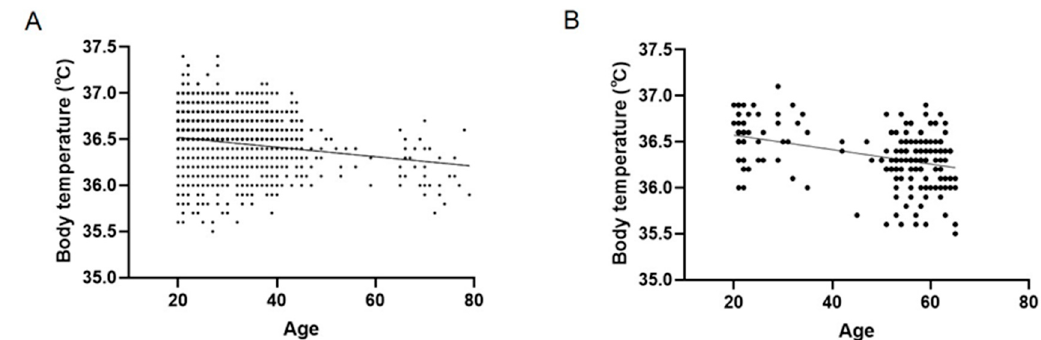
Figure 2. Correlation of age and body temperature in healthy Japanese male adults ( A ) and female adults ( B ).